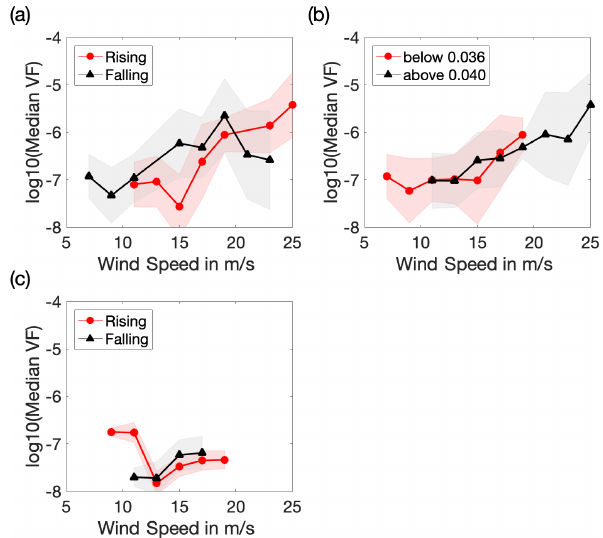
Figure 9. Median void fraction in each 2ms − 1 wind speed bin for all deployments. (a) Data from 2m depth, split into periods of ris- ing and falling winds (separated using hourly averages as described in the main text). (b) The same data from 2m depth split by in- verse wave age, representing developing ( > 0 . 04) and mature seas ( < 0 . 036). Shading represents the standard deviation at each wind speed. There were no bubble camera data for mature seas when the wind speed was greater than 19ms − 1 . Panel (c) shows the resonator data (from 4m depth) separated by wind speed. There is insufficient resonator data for a comparison with inverse wave